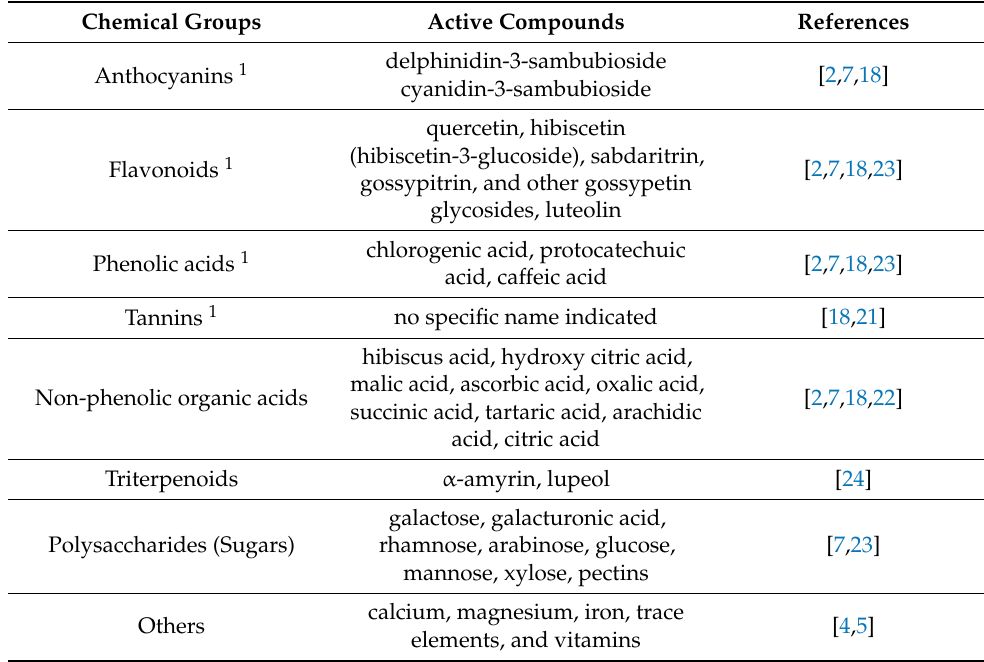
Table 1. Active chemical compounds in Hibiscus sabdariffa